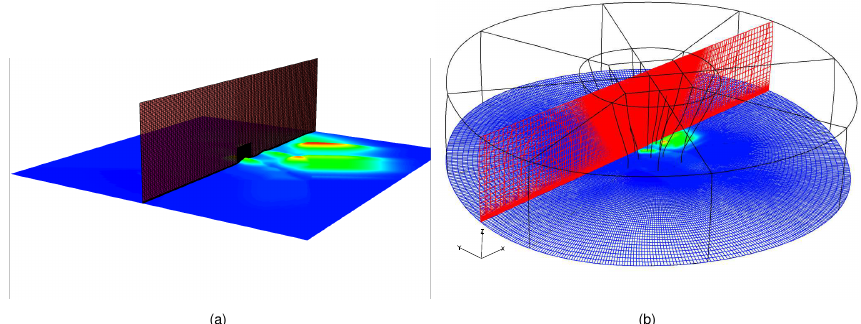
Figure 2. Askervein Hill: volume grid generated with (a) SnappyHexMesh and (b) HypGrid.